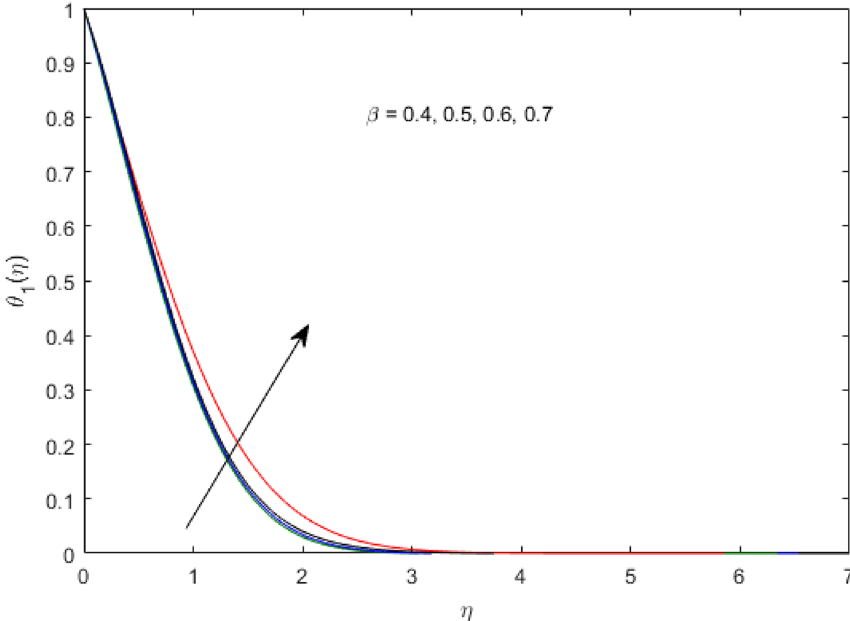
Figure 3. θ 1 (η) versus varied estimates of β .